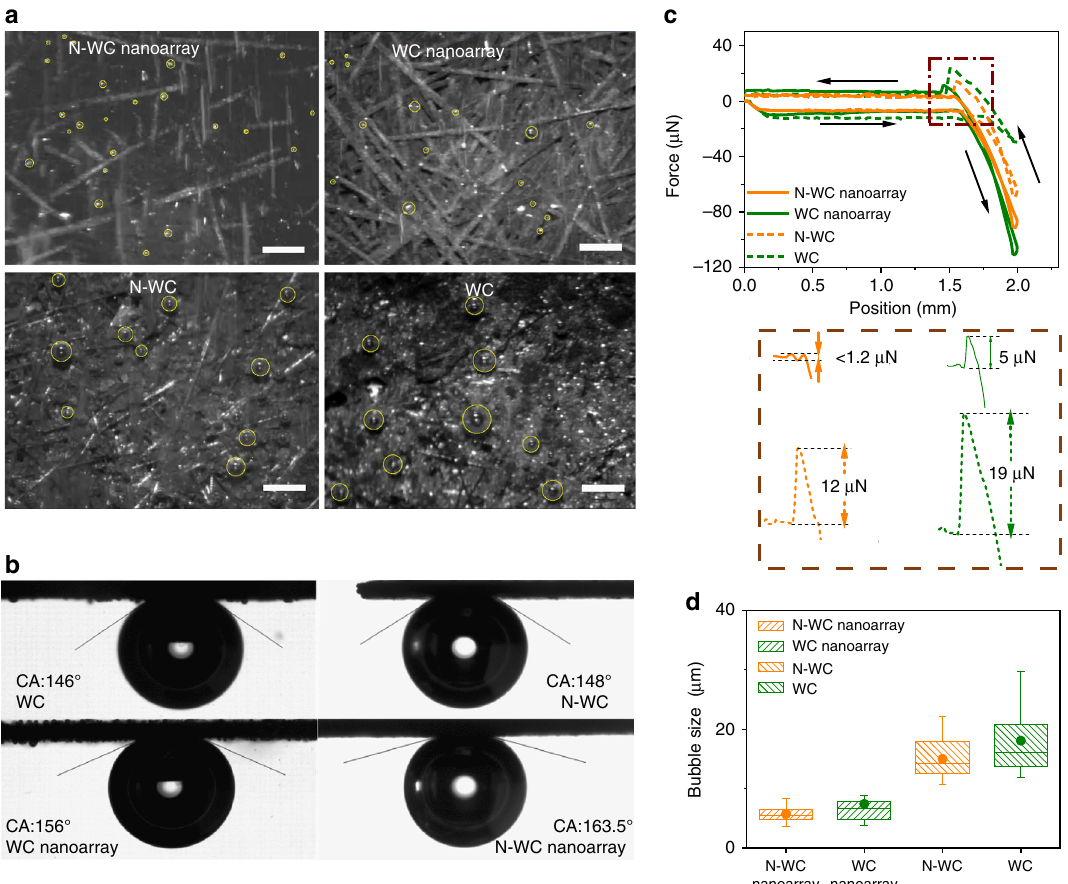
Fig. 5 Bubble behavior study. a Snapshots of bubbles detaching from different electrodes at − 200 mV vs. RHE. b Bubble contact angles, c bubble adhesion forces, and d bubble size distributions on different electrodes of WC, WC nanoarray, N-WC, and N-WC nanoarray. Scale bar in a : 100 μ